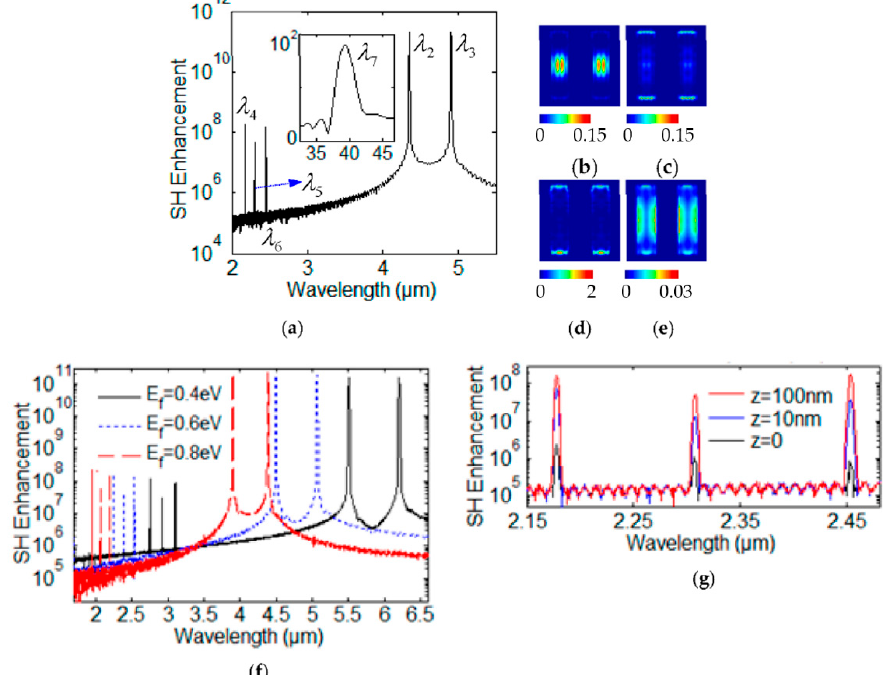
Figure 7. ( a ) Log plot of the spectrum of SH response. The distributions of Φ with different wave- lengths ( b ) λ 4 , ( c ) λ 5 , ( d ) λ 6 , ( e ) λ 7 . ( f ) Log plot of the SH enhancement factor with three different Fermi energy E f = 0.4 eV, 0.6 eV and 0.8 eV, respectively. ( g ) Log plot of the SH enhancement factor with three different position z = 0, z = 10 nm and z = 100 nm away from the graphene layer, respectively.